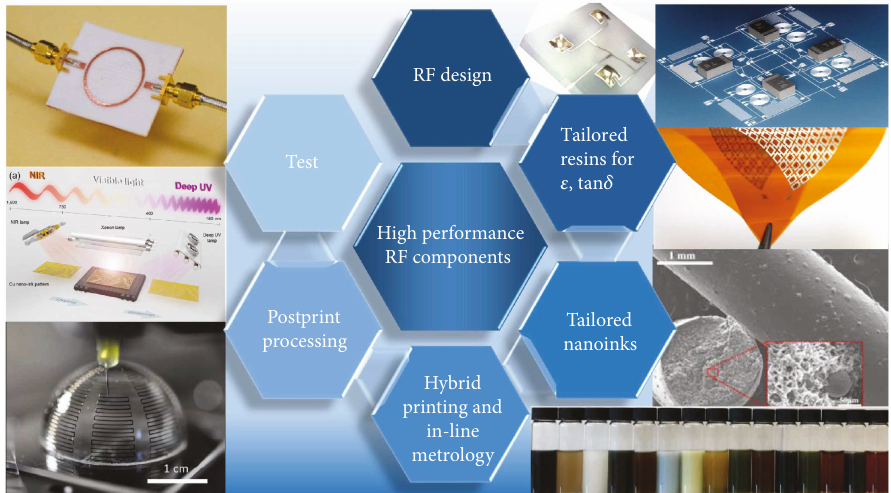
Figure 1: Methodology to obtain desired high performing RF components. Beginning with the initial RF component design, tailor the ink and resin chemistry around the required performance. Next, determine printing method(s) that would ideally have in-line metrology for surface pro fi les. The postprint processing is the key and needs to be compatible with materials chosen and end properties desired. Testing or characterization validates the initial design. Adapted with permission from [9, 14 –